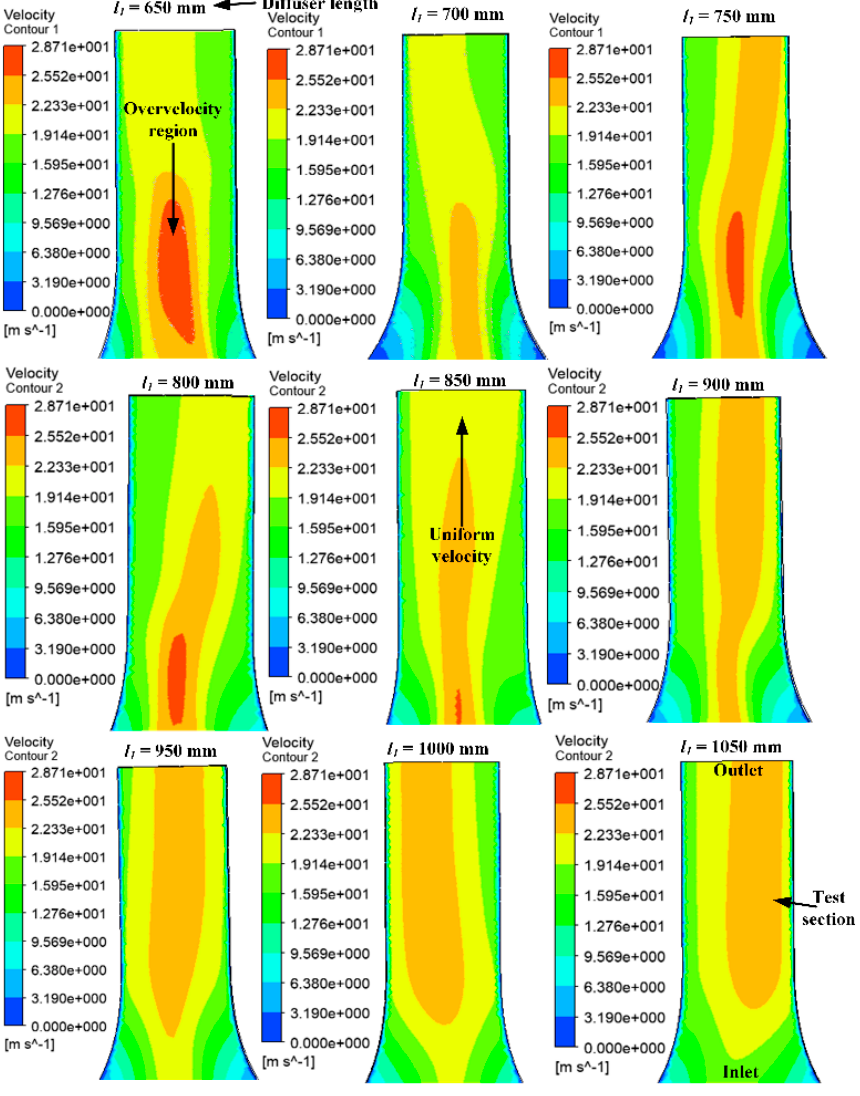
Figure 4. Velocity contour at various diffuser lengths.